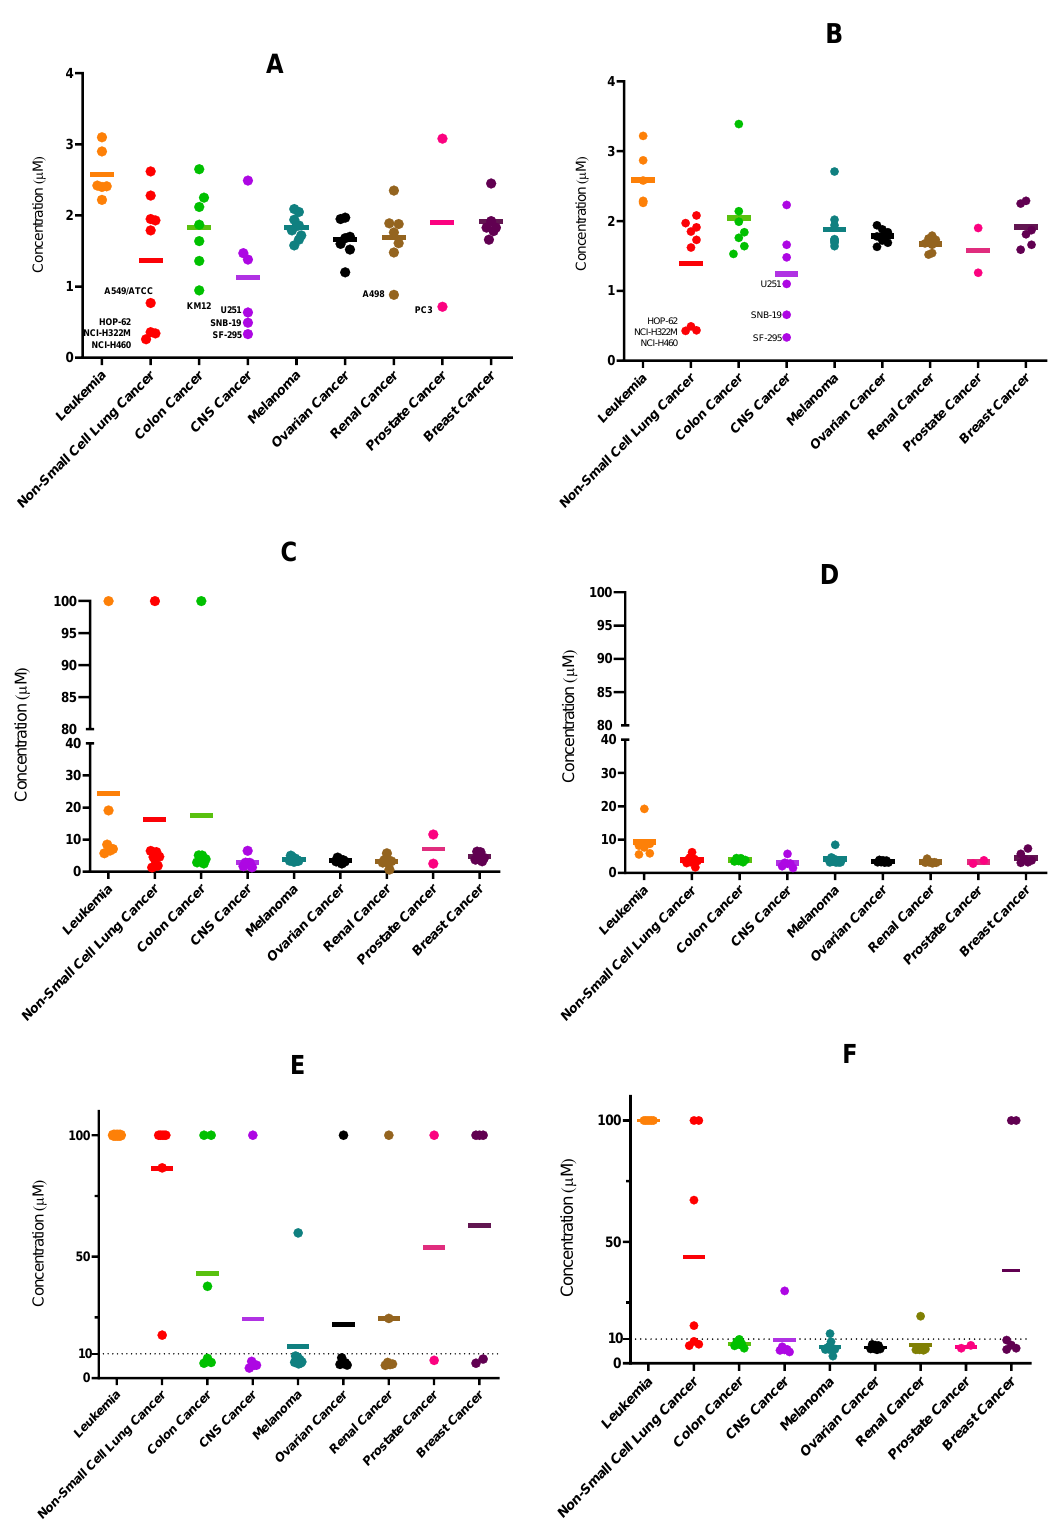
Figure 5. Representation of GI 50 ( A , B ), TGI ( C , D ), and LC 50 ( E , F ) values of compounds 14a ( A , C , E ) and 17a ( B , D , E ) in the 60 cancer cell lines tested and grouped by cancer type. Values over 100 µ M are represented as 100 µ M. The LC 50 values of some cell lines were not determined. Blue lines represent mean value in each cancer type.